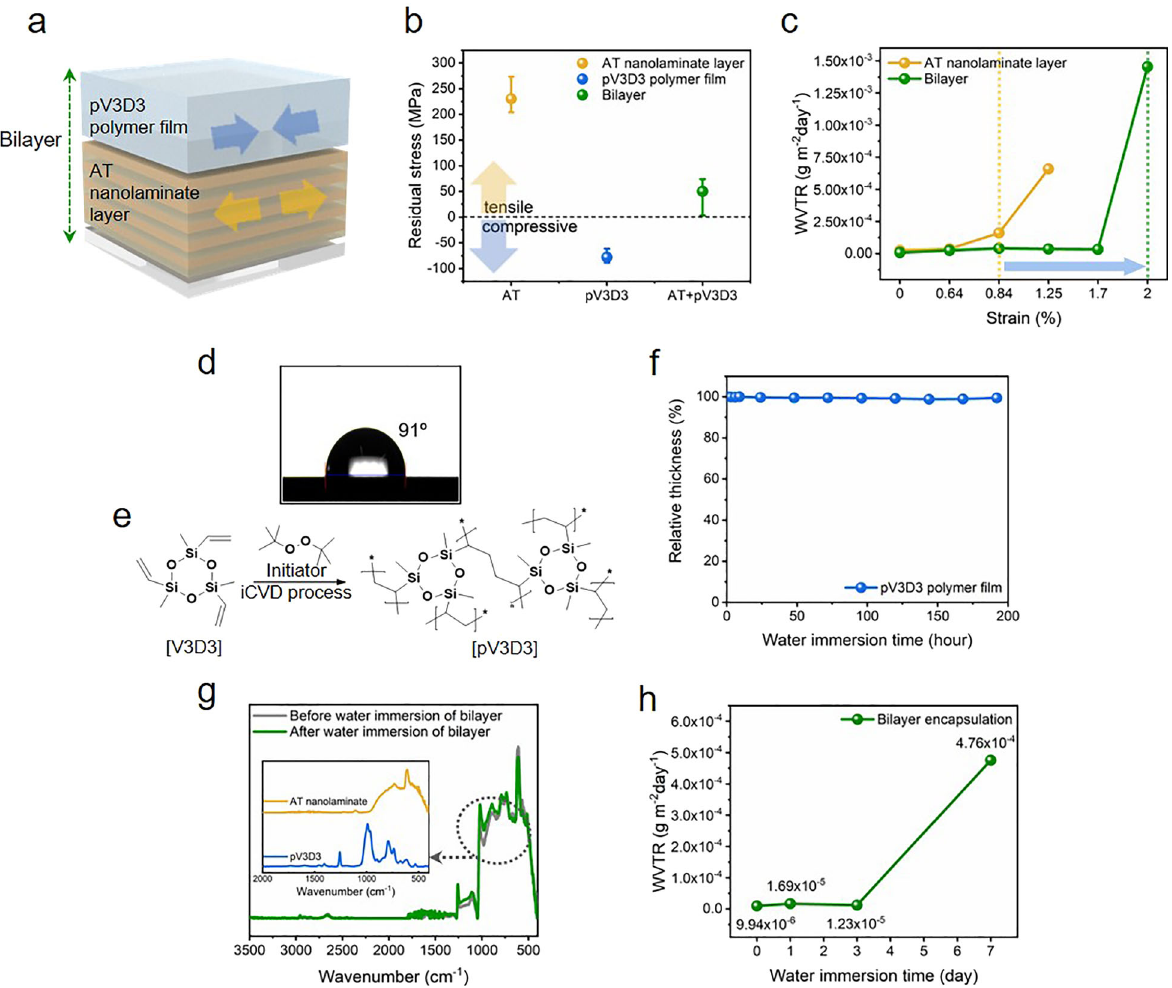
Fig. 4 Foldable and washable encapsulation layer. a Illustration of the method for controlling residual stress utilizing the residual stress in each layer. b Residual stress in the Al 2 O 3 /TiO 2 nanolaminate layer (AT nanolaminate layer), pV3D3 polymer fi lm, and bilayer. c WVTR of the barriers after 1000 times bending as a function of bending strain. d Contact angle of the pV3D3 polymer fi lm. e Chemical structure of the V3D3 monomer, initiator, and pV3D3 polymer. f Thickness of the pV3D3 polymer fi lm as a function of water immersion time. g FT-IR spectra of the bilayer before/after water immersion for 10 days. h WVTR of the bilayer as a function of the dipping time (with error bars that indicate standard